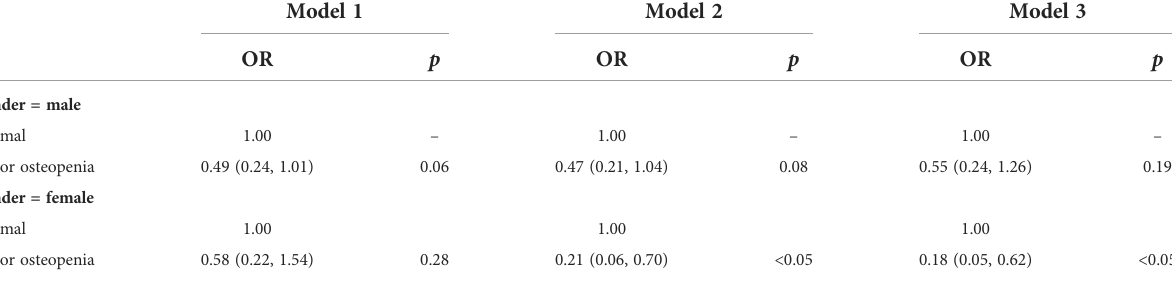
TABLE 4 Association between taking antiplatelet agents and OP or osteopenia (subgroup analysis strati fi ed by